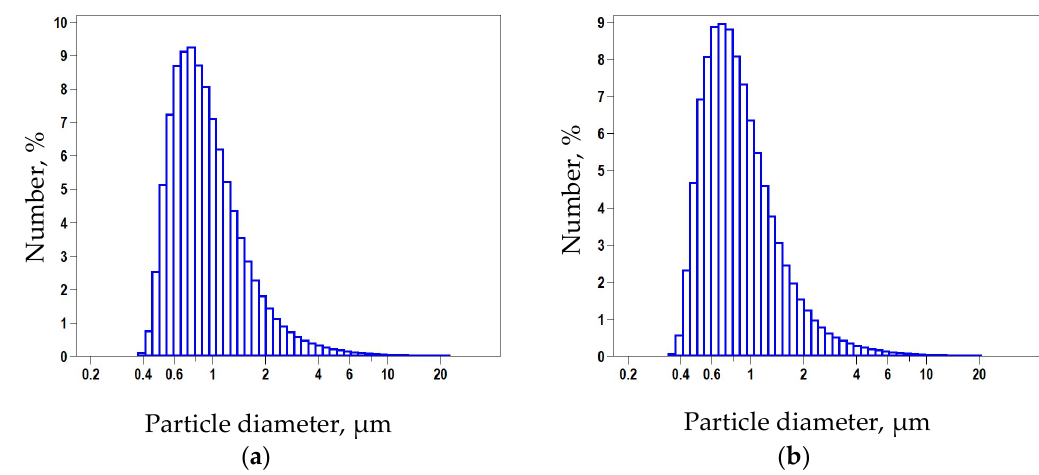
Figure 3. Average size distribution measured by dynamic light scattering: ( a ) pristine DND; ( b ) DNDamine.